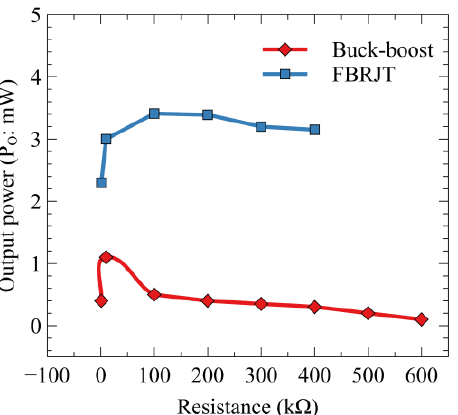
Figure 16. Comparison of the proposed circuit with the literature circuit, ( a ) FBRJT, ( b ) buck-boost circuits (i.e., Figure 3).